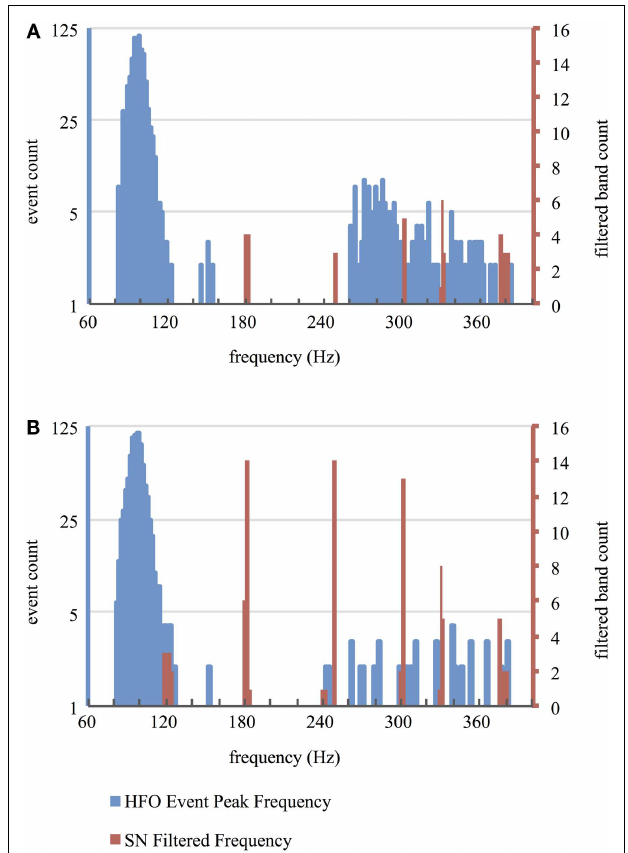
FIGURE 4 | Frequency of HFOs and SN filtering . Histograms represent the distribution of peak frequency content of HFOs validated from the entire duration of recording segments using semi-automated methods (blue) as well as frequency bands removed using the SN filter (red) for macro-contacts (A) and micro-contacts (B) .